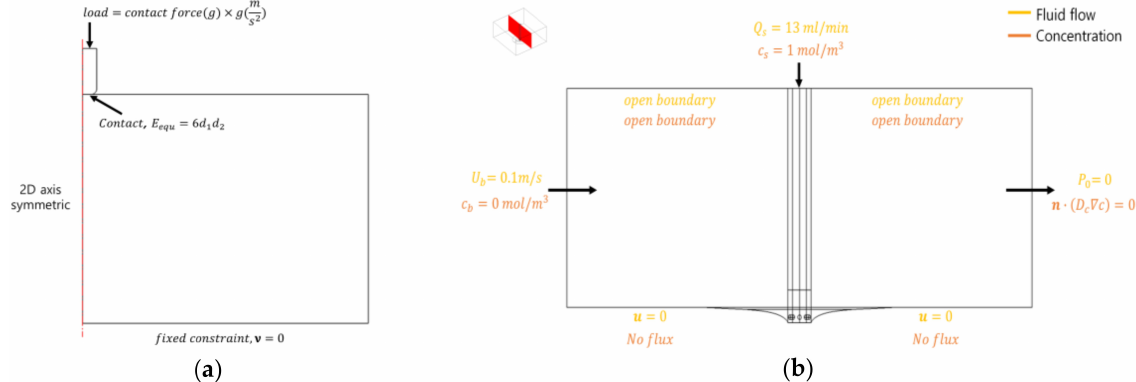
Figure 4. Boundary conditions of the deformation model of heart tissue ( a ) and the mixing model between saline and blood flow ( b ).